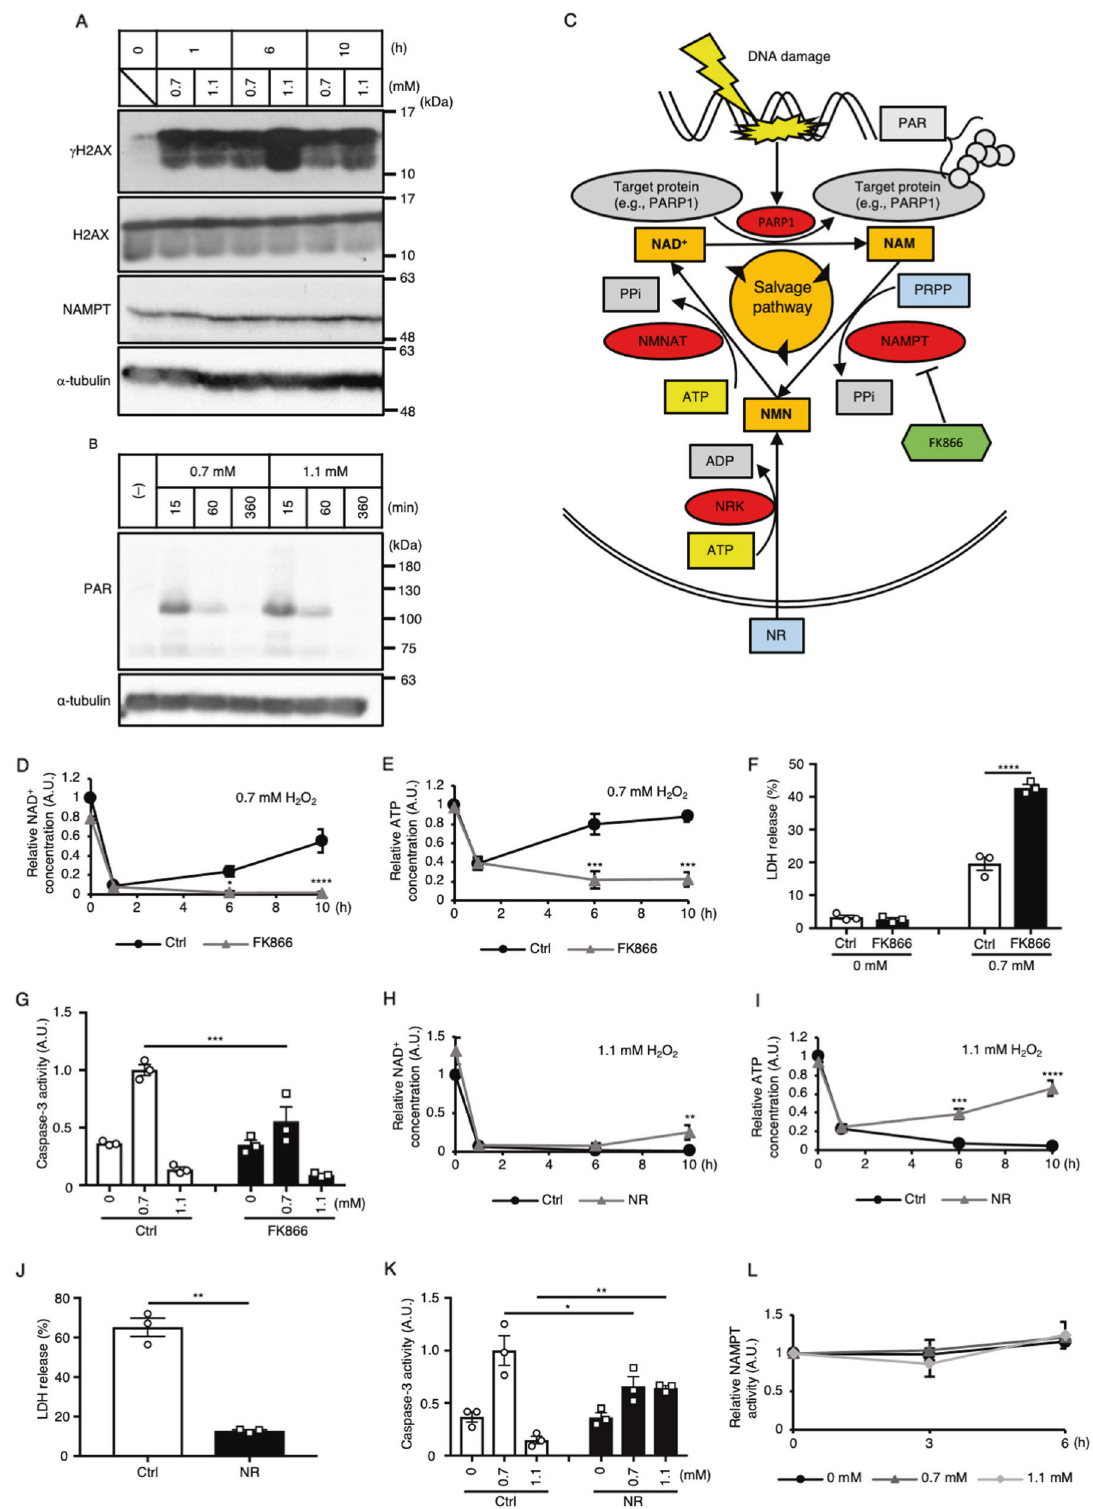
The NAMPT-dependent NAD + salvage pathway is necessary for the recovery of NAD + and induction of apoptosis under weak H 2 O 2 stimulation The intracellular NAD + concentration is controlled by the balance between NAD + consumption and production. Therefore, we